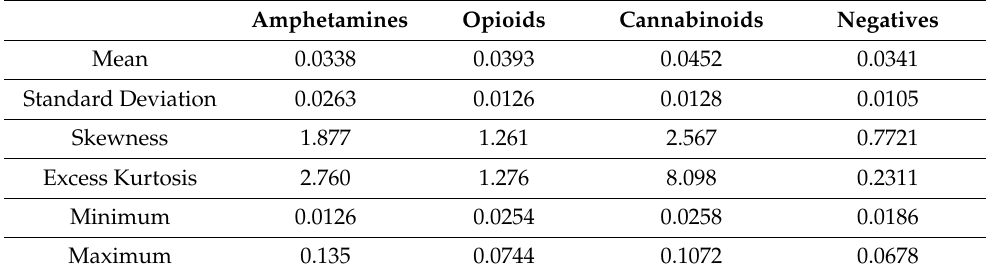
Table 2. Statistical parameters calculated based on the mean ATR-FTIR spectra of the targeted clas- ses of compounds, between 1500 and 4000 cm −1 , with a resolution of 1.92 cm −1 . of compounds, between 1500 and 4000 cm − 1 , with a resolution of 1.92 cm − 1